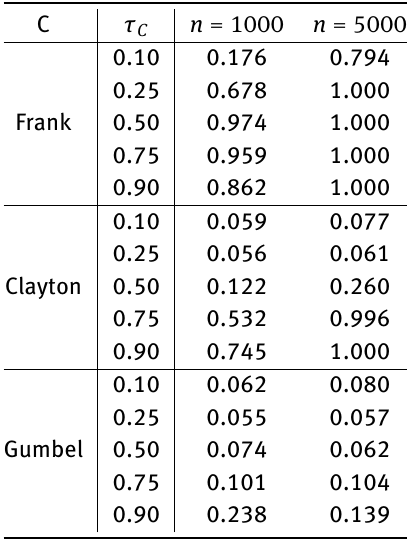
Table 8: d = 6 : Empirical power of the test for ellipticity with significance level α = 0.05 based on the test statistic T n : rate of rejecting H 0 as observed in 1000 random samples of size n from copula family C with Kendall’s tau τ C